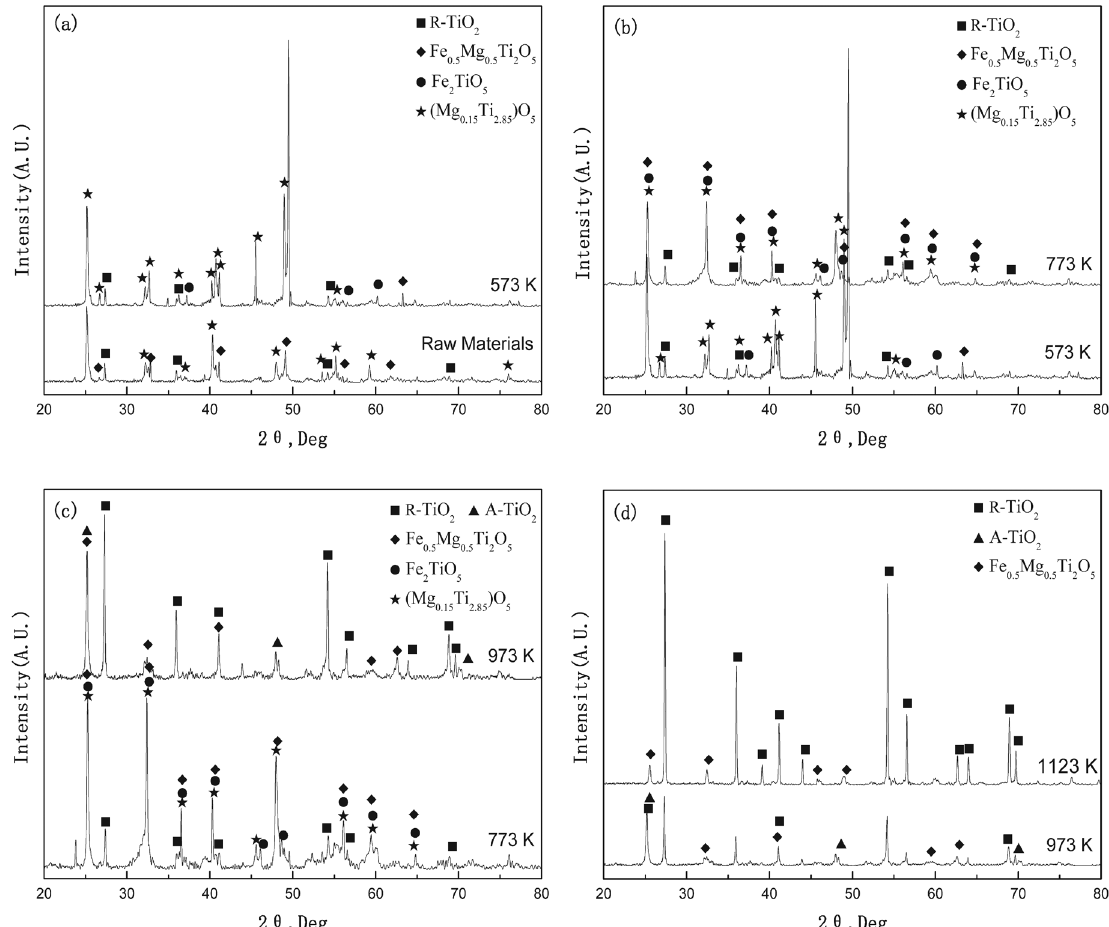
Fig. 5: XRD patterns of roasted product: (a) 573 K roasted vs. raw material; (b) 773 K roasted vs. 573 K roasted; (c) 973 K roasted vs. 773 K roasted; (d) 1223 K roasted vs. 973 K